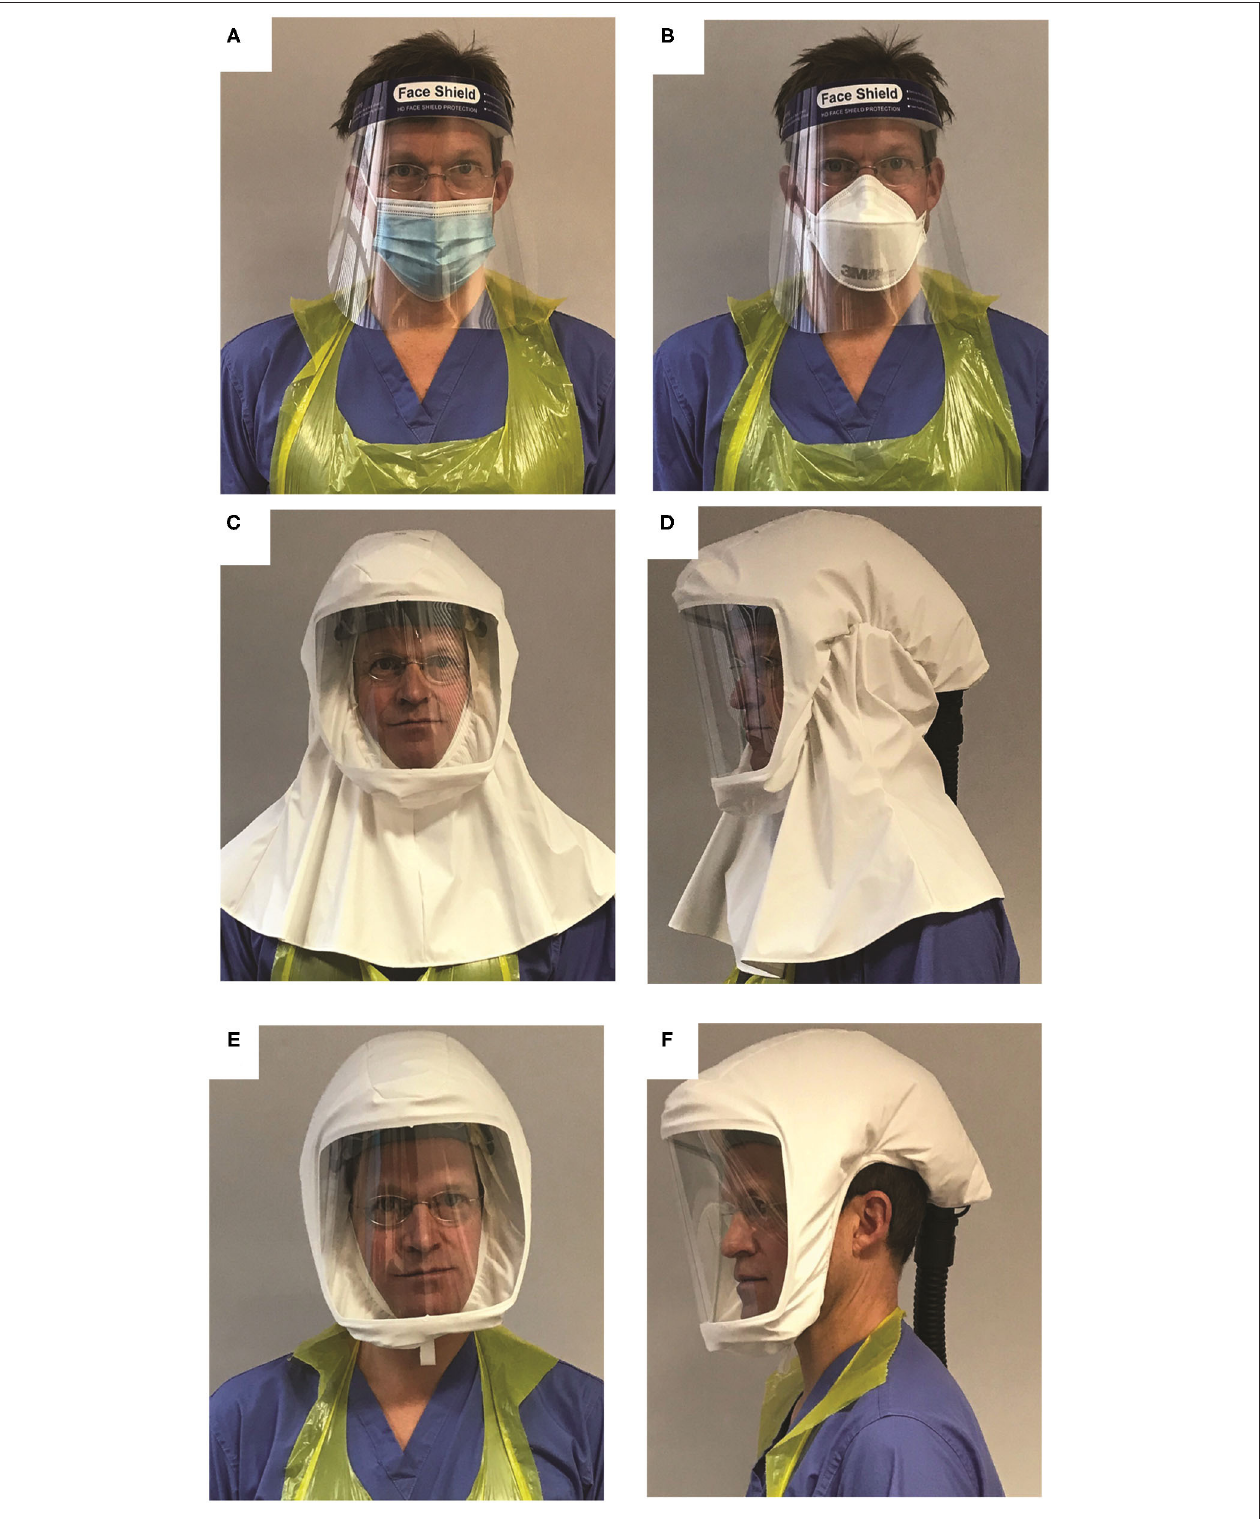
FIGURE 1 | Types of PPE described in the manuscript. (A) Droplet protection: a disposable Type IIR surgical mask and visor. (B) Aerosol protection: a disposable tight fitting FFP3 mask and visor. (C,D) PeRSo with the long hood type, which was the type issued during the period of the survey. (E,F) PeRSo with short hood type that exposes the ears, developed in response to the initial user feedback. In all instances, a plastic apron and gloves complete the PPE.